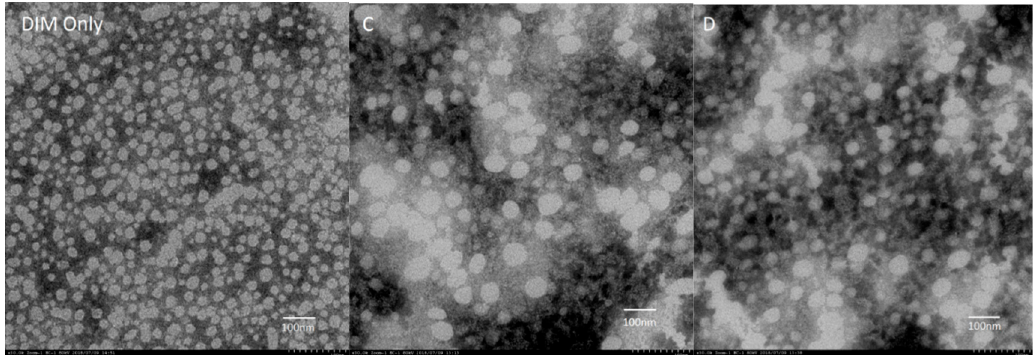
Figure 3. Images of DIM, PWPC only, and PWP/DIM with different mass ratios represented with ( A ) PWP/DIM (5:1), ( B ) PWP/DIM (10:1), ( C ) PWPC/DIM (15:1), and ( D ) PWP/DIM (20:1).